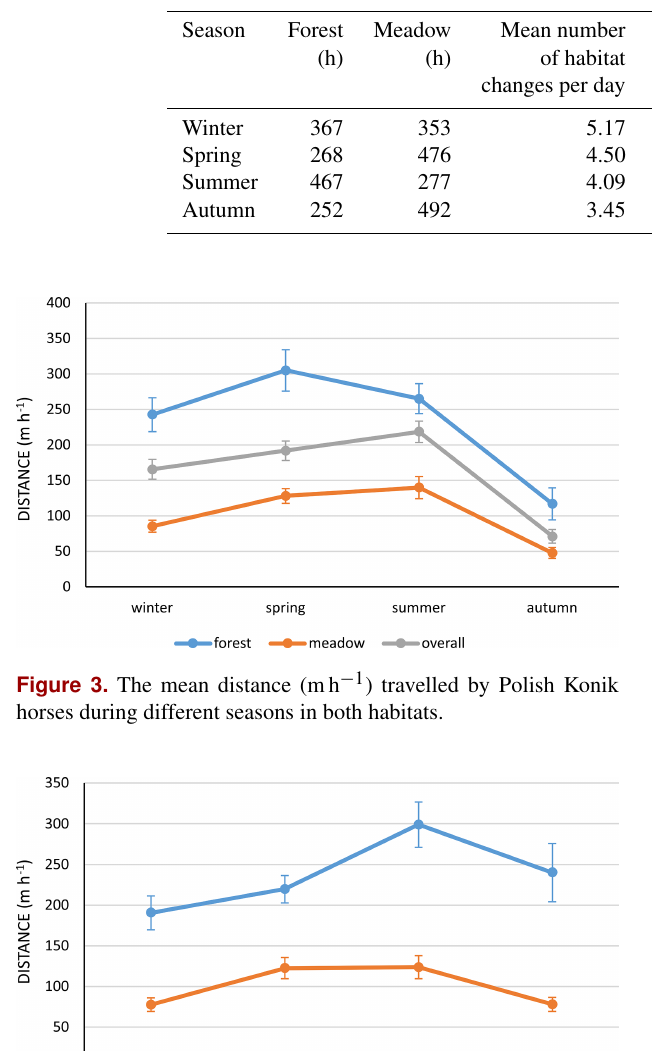
Table 3. Total time during which horses remained in different habitats and the frequency of habitat change during the day.